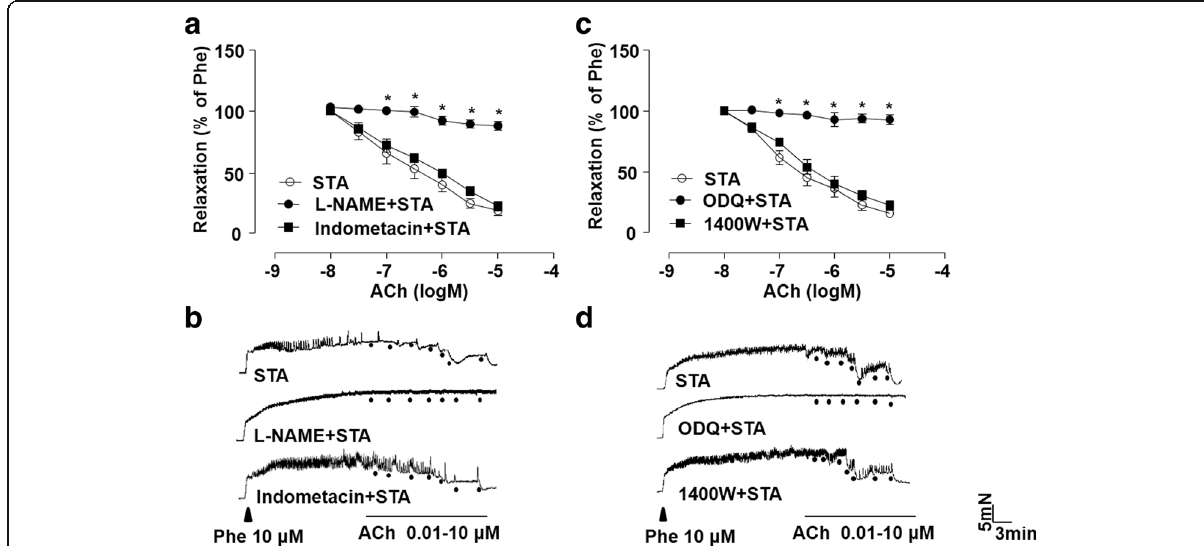
Fig. 2 STA-improved relaxation was dependent on endothelium-derived NO. Rat thoracic artery rings were incubated with STA (10 μ M) for 12 h and exposed to L-NAME (100 μ M), indomethacin (1 μ M) ( a ), 1400 W (100 nM) or ODQ (3 μ M) ( c ) for 30 min before the PE-contraction and ACh- induced relaxation. b and d Representative traces of endothelium-dependent relaxations as in ( a and c ). Data were shown as mean ± SEM; n = 5, * P < 0.05 vs. Vehicle